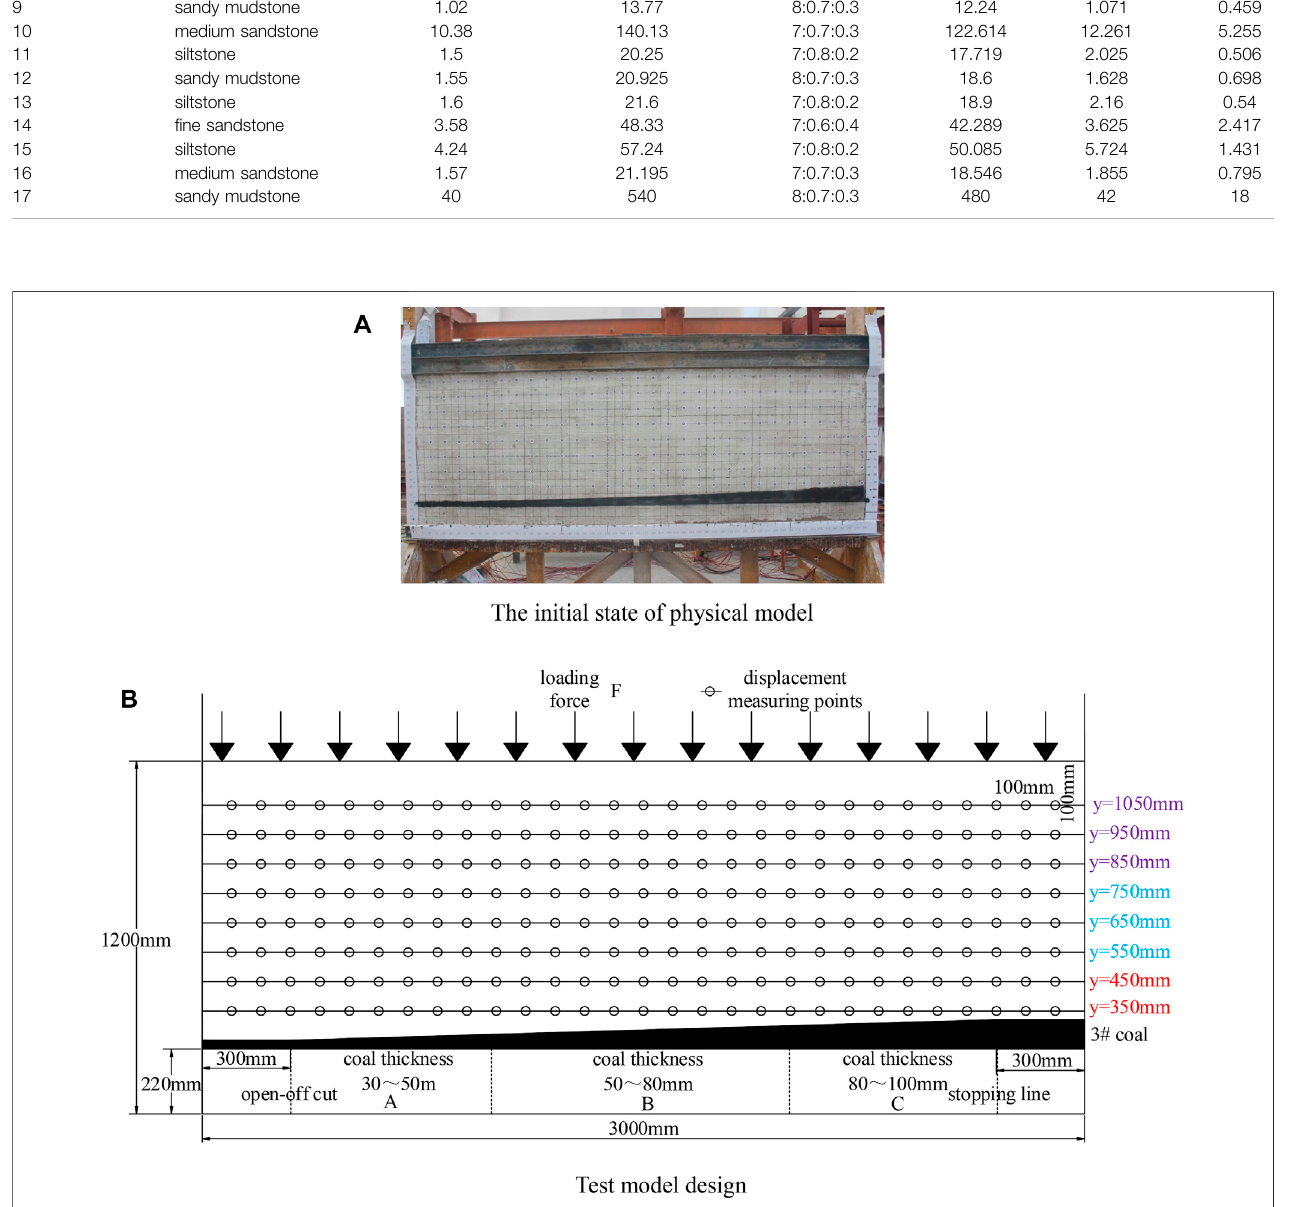
Frontiers in Earth Science |